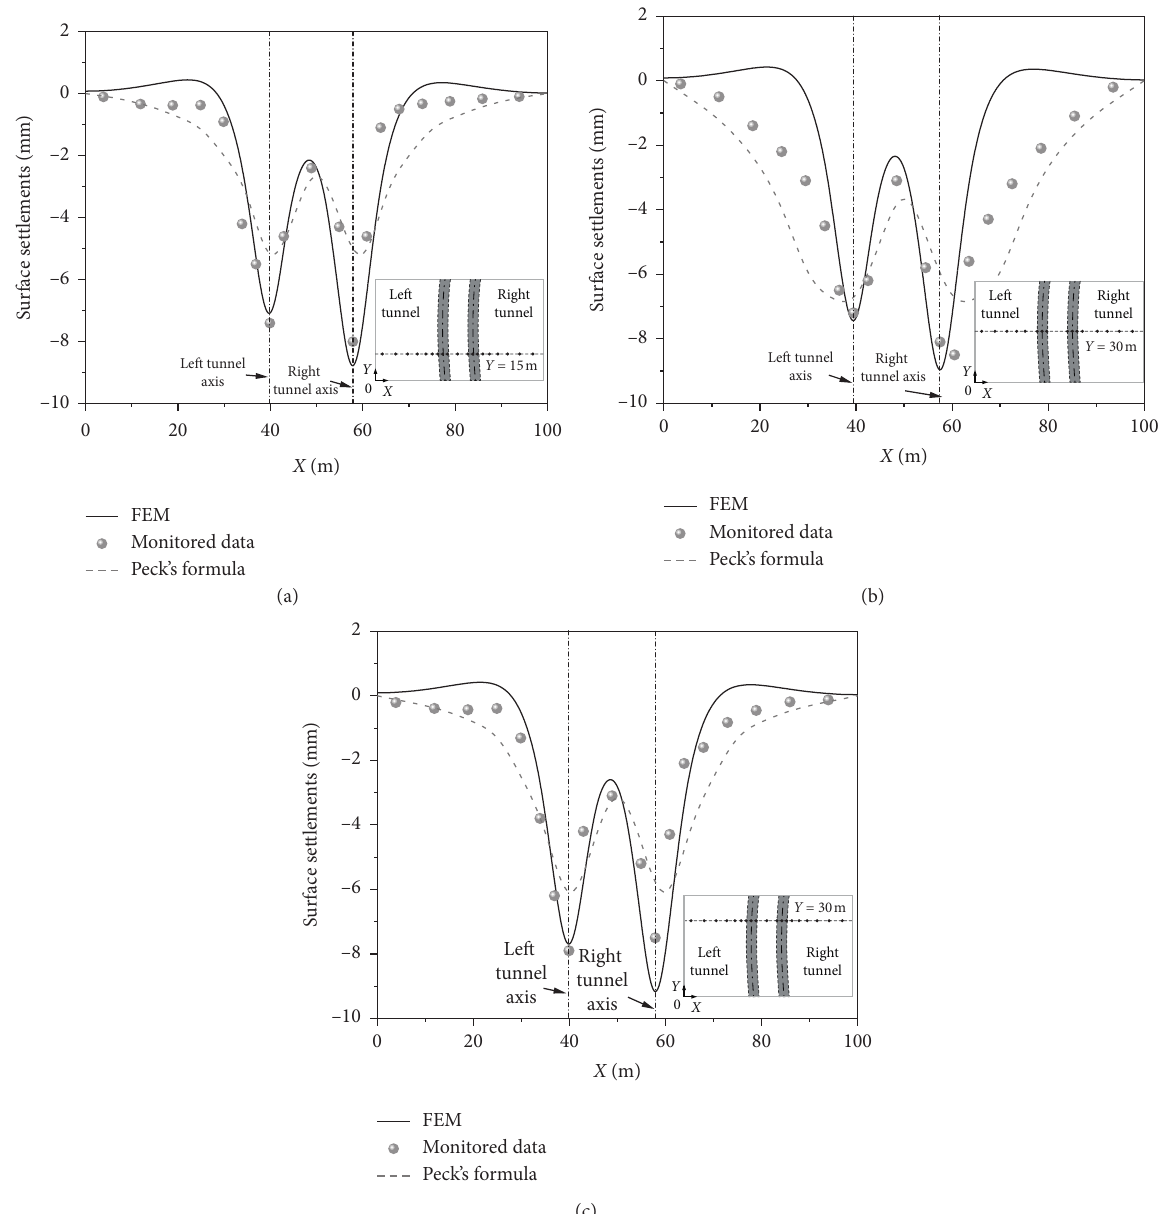
Figure 8: Ground surface settlement troughs at the final step induced by curved tunnelling of 300 m in radius of curvature along: (a) Y � 15 m, (b) Y � 30m, and (c) Y �